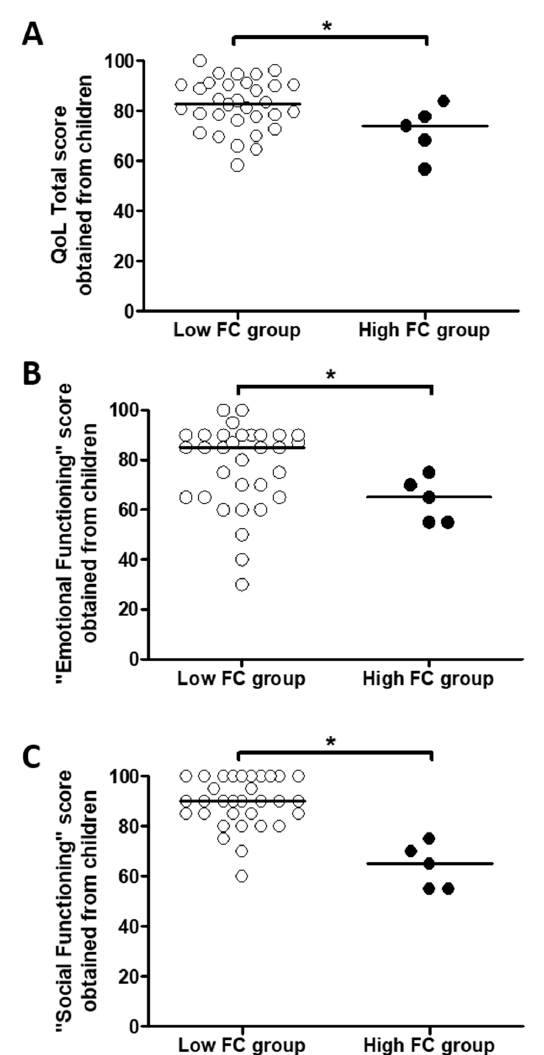
Figure 2. Differences in Quality of Life Pediatric Inventory 4.0-PedsQL TM scores according Fecal calprotectin (FC) level. Differences between the Quality of life (QoL) Total score ( A ), the “Emotional Functioning” score ( B ) and the “Social Functioning” score ( C ) obtained from children according to the presence (High FC group) or not (Low FC group) of fecal calprotectin level >250 µg/g of stool. Comparisons were performed with Mann–Whitney tests. * p < 0.05 .